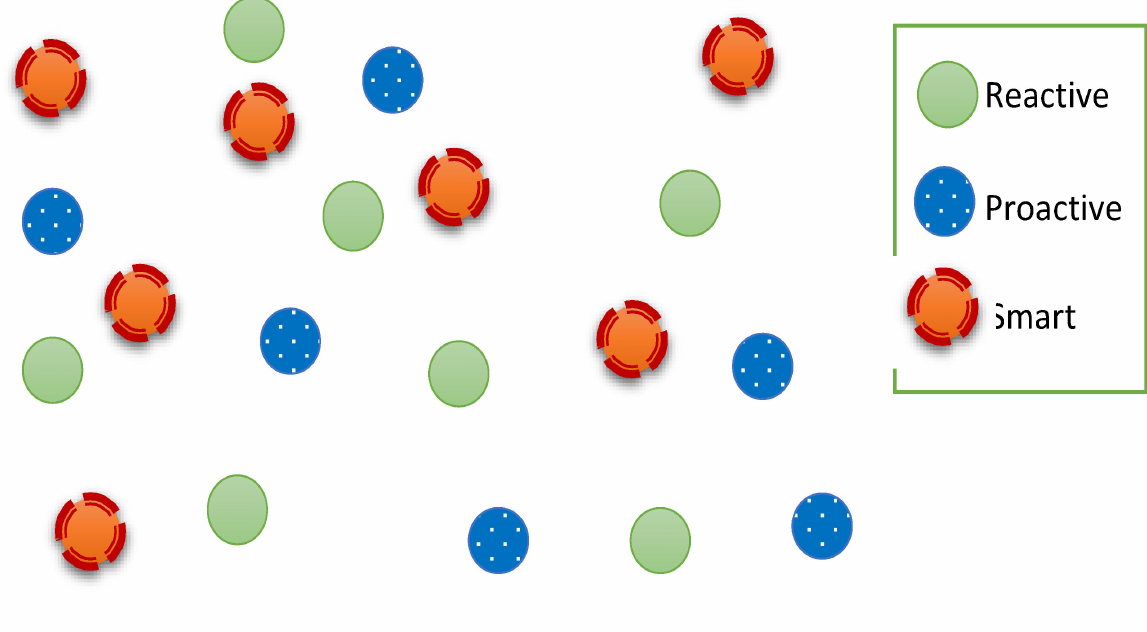
Figure 4. Dissimilar nodes are randomly deployed in the same